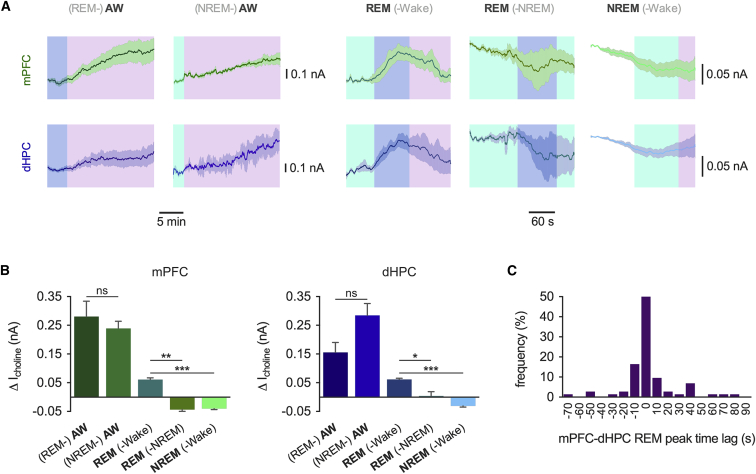
The Dynamics of Tonic Acetylcholine Release Predict Behavioral Sequences(A) Example choline currents for each behavioral state sequence. Background shading is color coded for behavioral state (AW, active wakefulness), measured state is in black, and preceding or following state is in gray. See Table 1.(B) Quantification of choline current changes for behavioral state sequences shown in (A) (n = 6 mice; ANOVA with Tukey HSD post hoc correction). Data are indicated as mean ± SEM.(C) Frequency distribution of the time lag, in seconds, between mPFC and dHPC REM (-Wake) choline peaks from REM onset.∗p < 0.05; ∗∗p < 0.01; ∗∗∗p < 0.001; ns, p > 0.05.